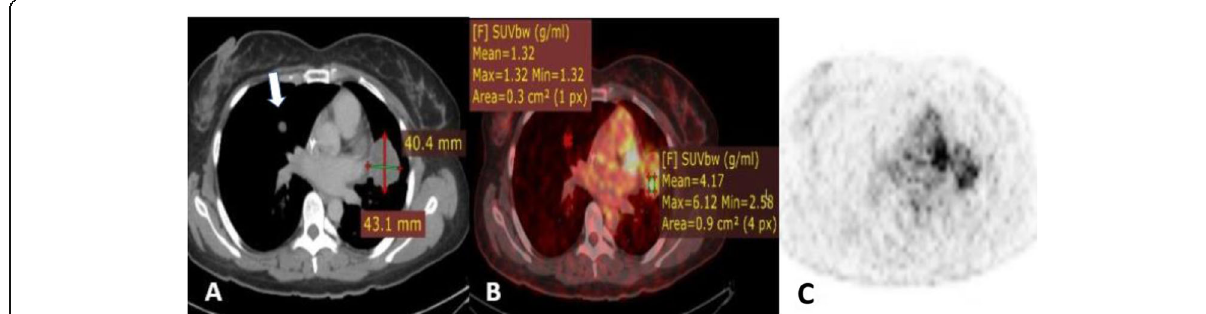
Fig. 6 A female patient 57 years old presented with attacks of hemoptysis and proven histopathologically to have NSCLC. CT study reveals a malignant mass lesion involving the left upper lobe with a small 5 mm pulmonary nodule involving the right middle lobe and considered a metastatic nodule (M1a) (white arrow, a ). The nodule showed insignificant FDG uptake as seen in b and c PET/CT images. The surgical staging of the patients by PET/CT changed from IVA to IIA